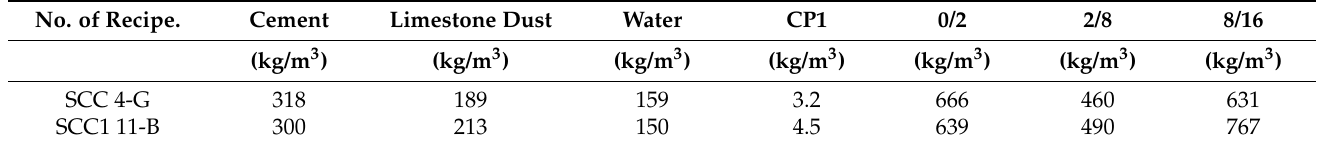
Table 12. The designed composition of self-compacting concretes.